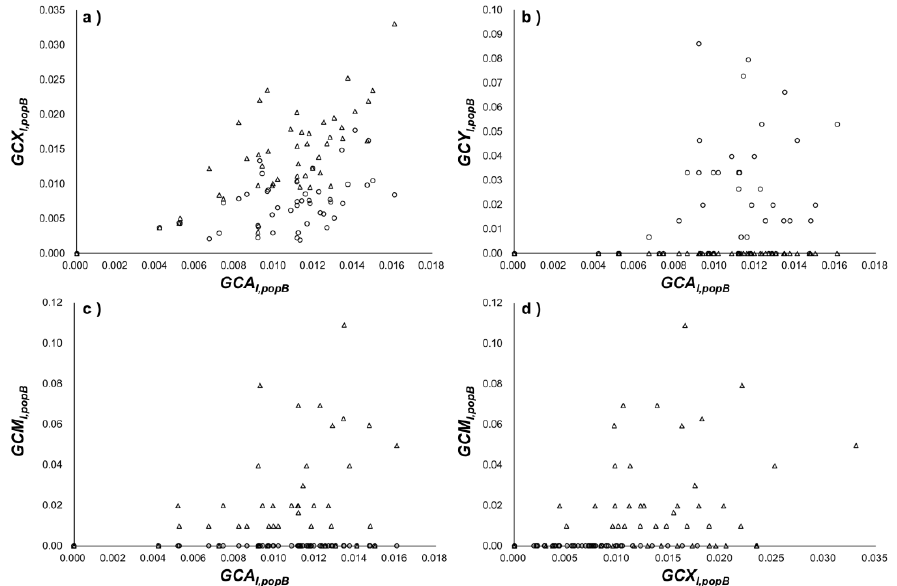
Figure 6. Comparison of average genetic contributions of 100 G1 mice to G8: ( a ) shows the relationship between GCA I,popB and GCX I,popB , ( b ) shows the relationship between GCA I,popB and GCY I,popB , ( c ) shows the relationship between GCA I,popB and GCM I,popB , and ( d ) shows the relationship between GCX I,popB and GCM I,popB . Circle: average genetic contributions of 50 G1 male mice to G8; triangle: average genetic contributions of 50 G1 female mice to G8.